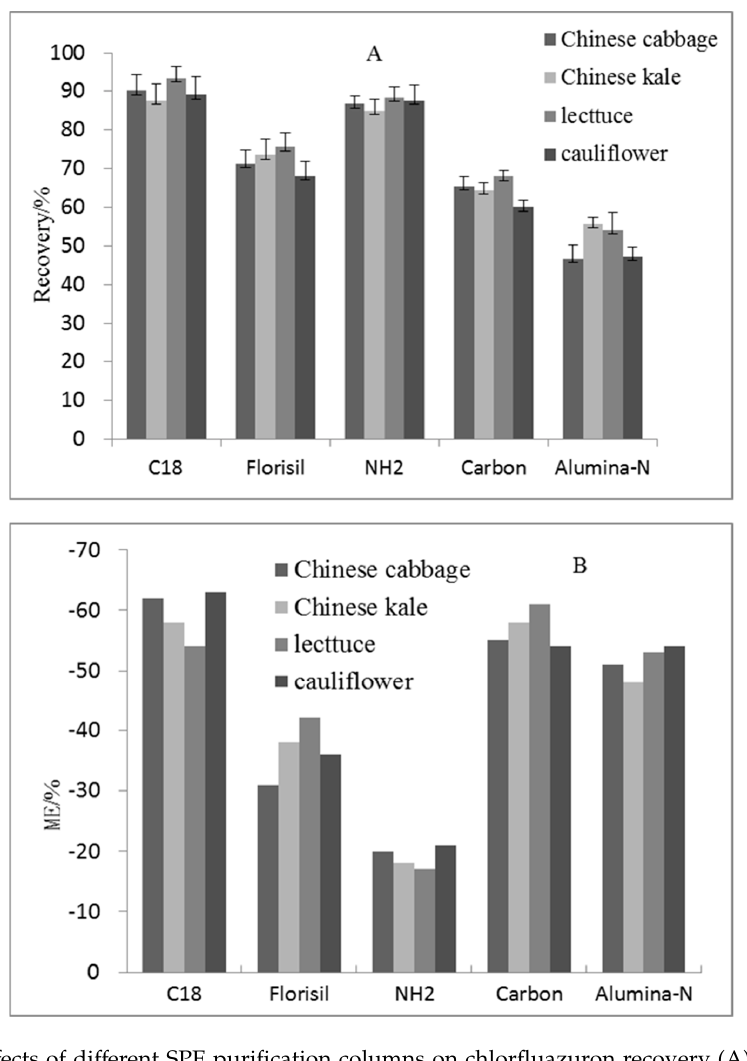
Figure 2. Effects of different SPE purification columns on chlorfluazuron recovery (A) and matrix effects (B) ( n = 5).